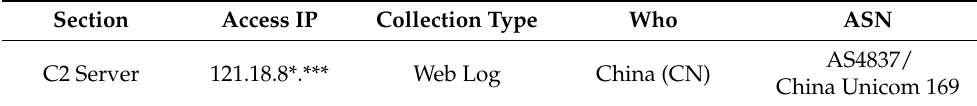
Table 6. Attack IP range confirmed on the abused server.